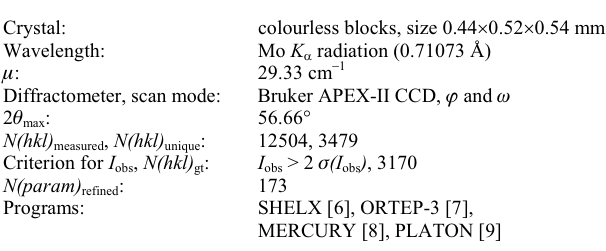
Table 1. Data collection and handling.